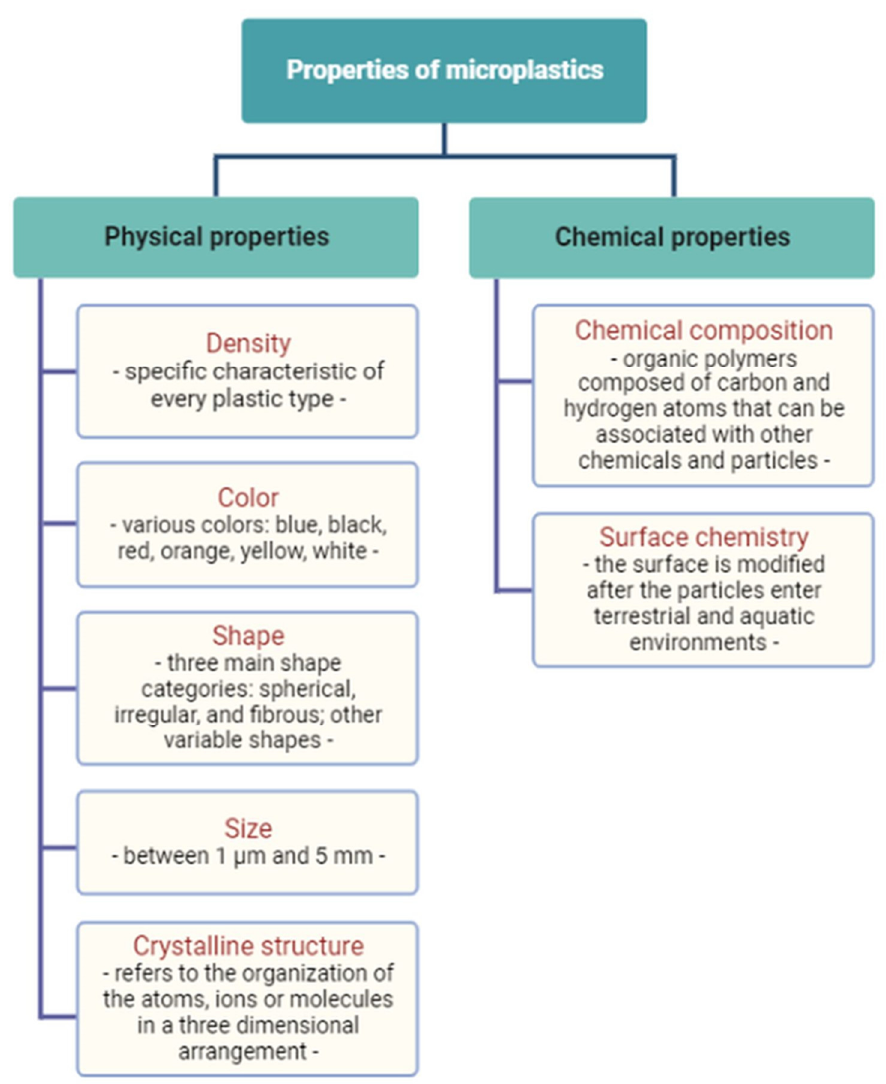
Figure 1. Physical and chemical properties of MPs. Diagram created in https://biorender.com/ (accessed on 11 September 2022).